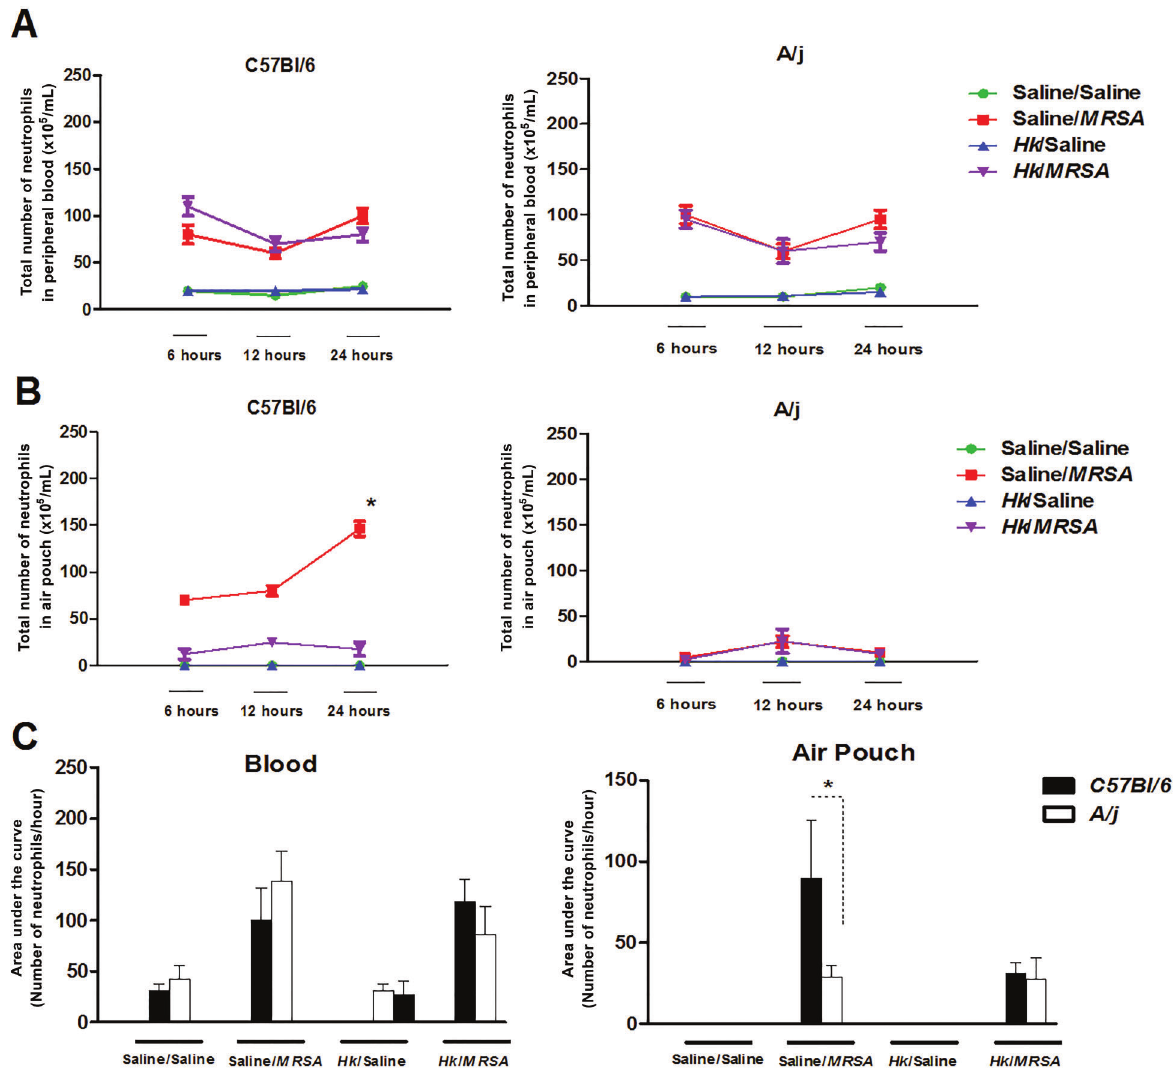
Figure 5. C57BL/6 and A/j mice previously immunized with 10 6 strains of MRSA inactivated by heat and challenged in the air pouch with 10 7 colony forming units (CFU) live MRSA. A , Total number of neutrophils in the peripheral blood. B , Total number of neutrophils present in the air pouch. C , Comparison the total number of neutrophils present in peripheral blood and air pouch. Data are reported as means ± SD. MRSA: methicillin-resistant Staphylococcus aureus ; Hk: Heat Killed. *P o 0.05 (Kruskal-Wallis test and Dunn ’ s post-test; Mann-Whitney test for comparisons between